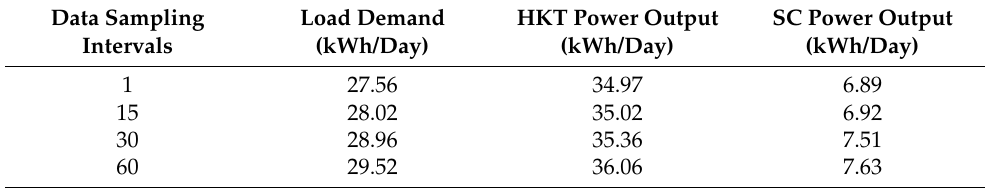
Table 1. Relative error of data measurements at different sampling intervals.